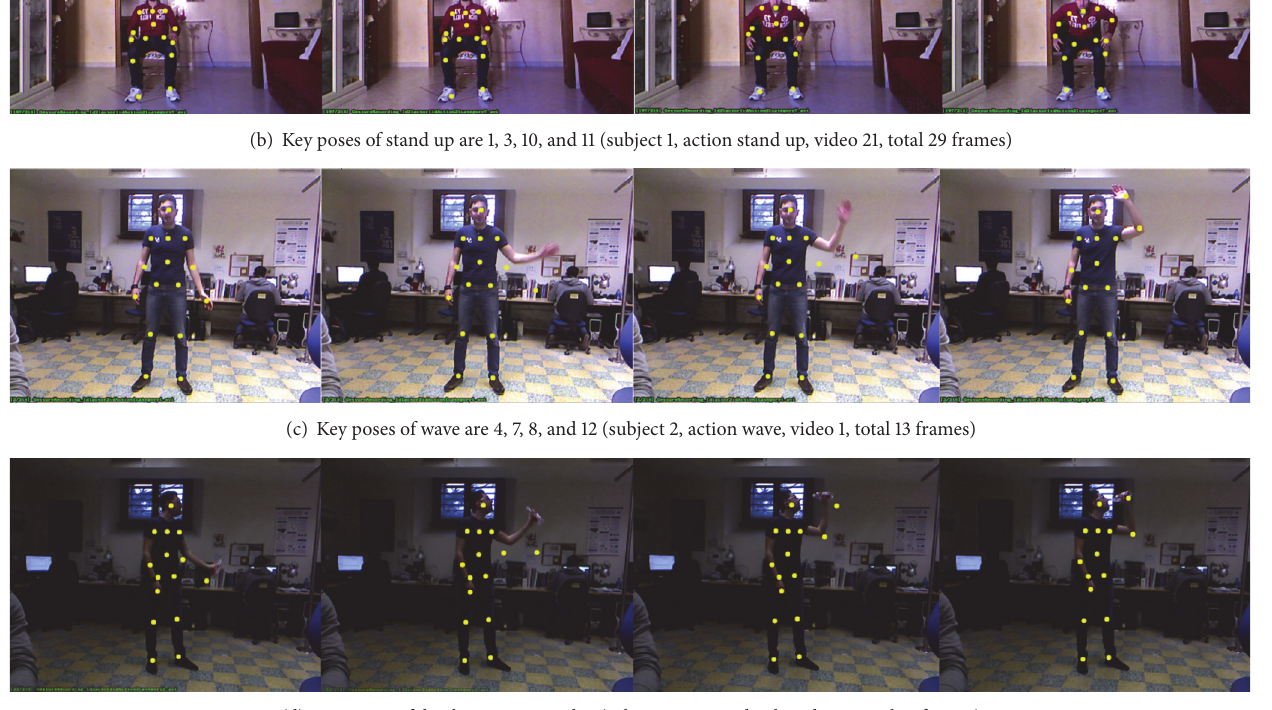
Figure 3: Key poses for different action in Florence 3D Actions